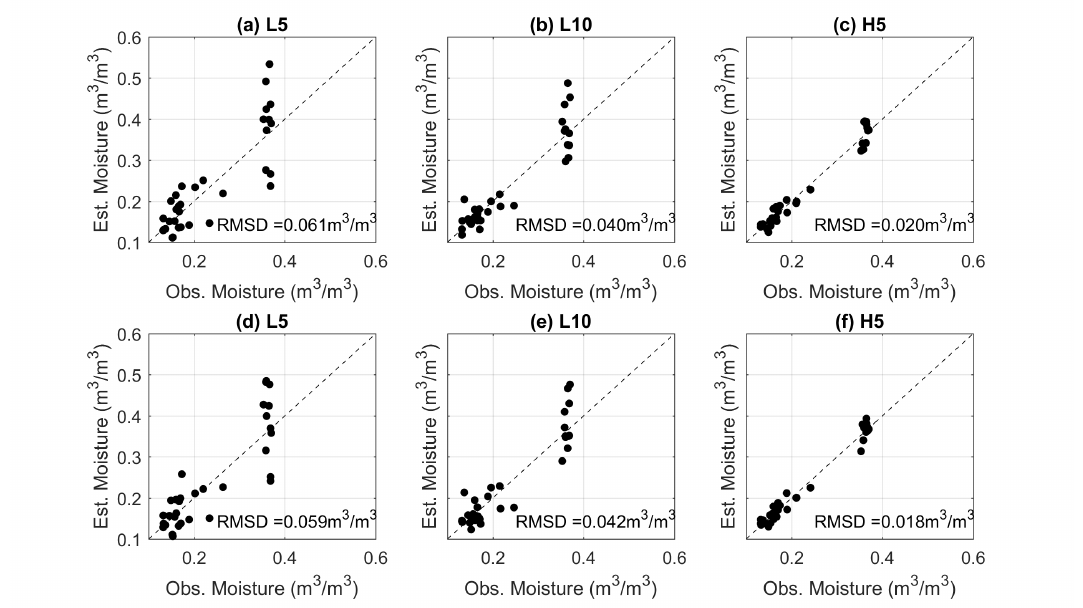
Figure 6. Comparison of the observed and the estimated soil moisture using the T cum method ( a – c ) and T max method ( d – f ). Soil moisture measurements at 2.5 cm were not